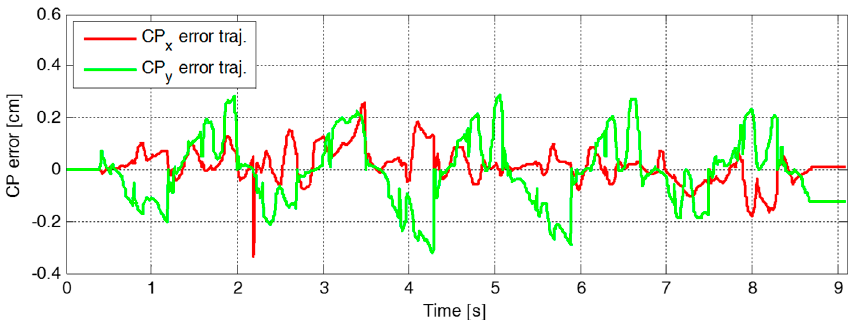
Figure 16. Snapshots of the experiment result with the proposed CP-based walking stability controller (left to right, top to bottom).